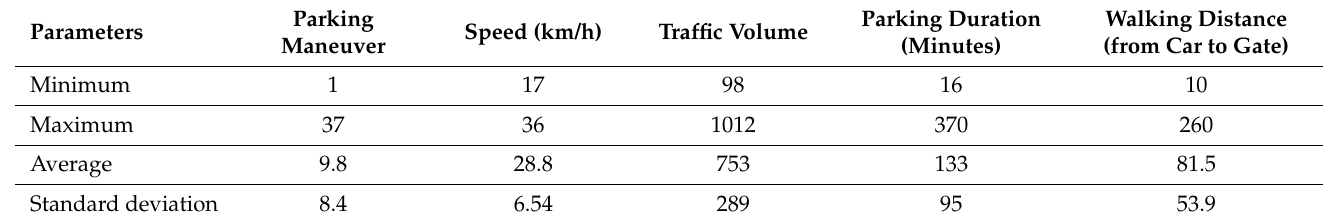
Figure 3. Traffic data distribution of ( a ) the number of maneuvers on both sides (indicated in grey and black colors) and ( b ) traffic volumes along the parking lot. Table 1. Descriptive statistics of the traffic data survey (per section).